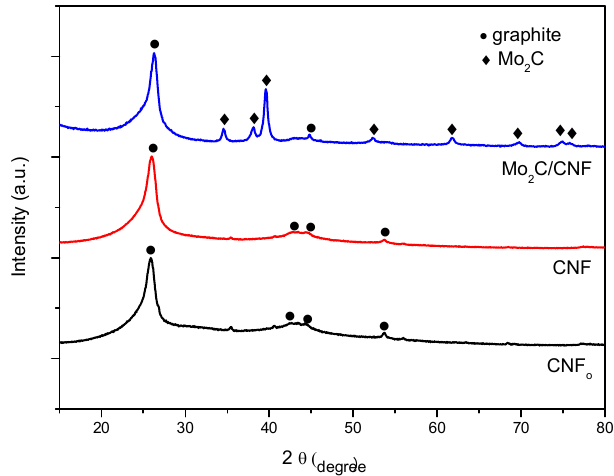
Figure 1. X-ray diffraction patterns of the catalysts.